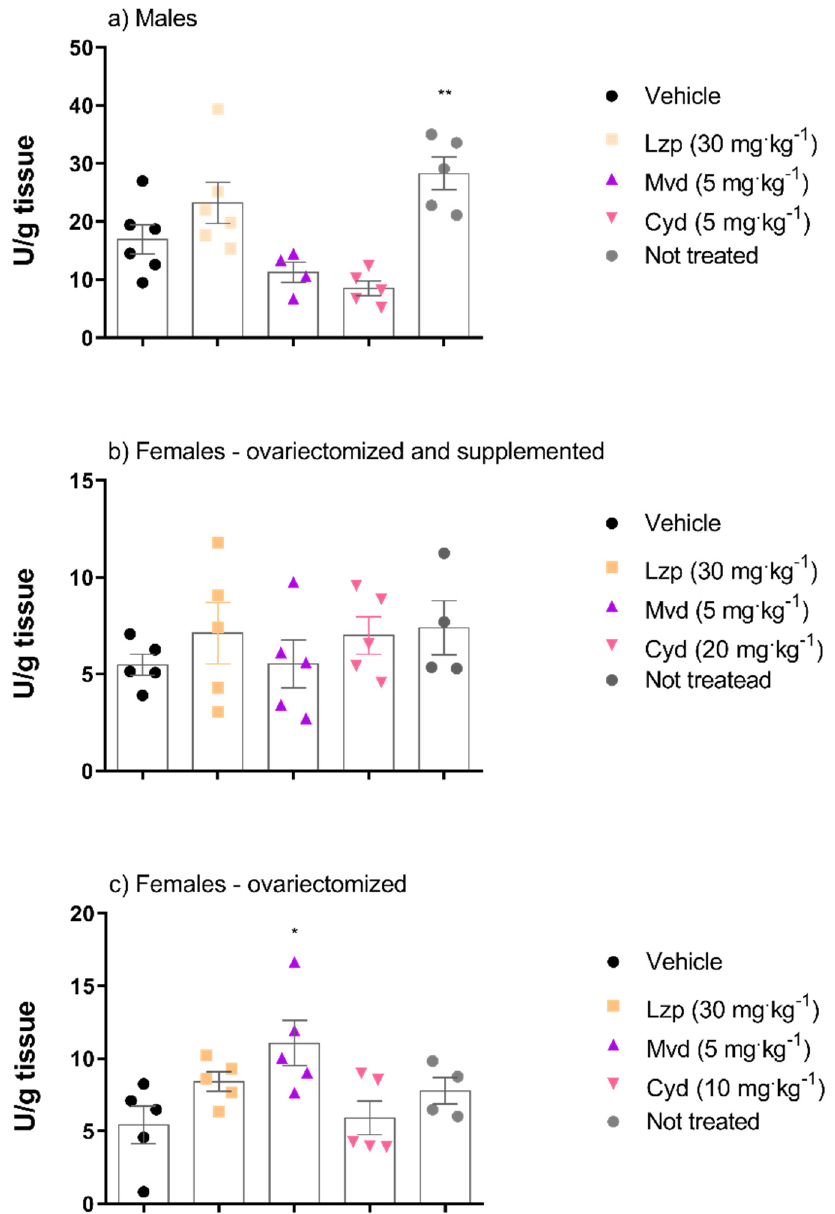
Figure 6. Effects of the malvidin or cyanidin chloride treatment on the SOD activity in the gastric lesions induced by ethanol in the different groups: ( a ) male animals, ( b ) female animals ovariectomized and supplemented with 17 β -estradiol (500 µ g/kg) and ( c ) group of ovariectomized female animals without supplementation. Data are presented as mean ± S.E.M. ANOVA followed by the Dunnett’s test; where * p < 0.05 and ** p < 0.01, compared to the respective vehicle